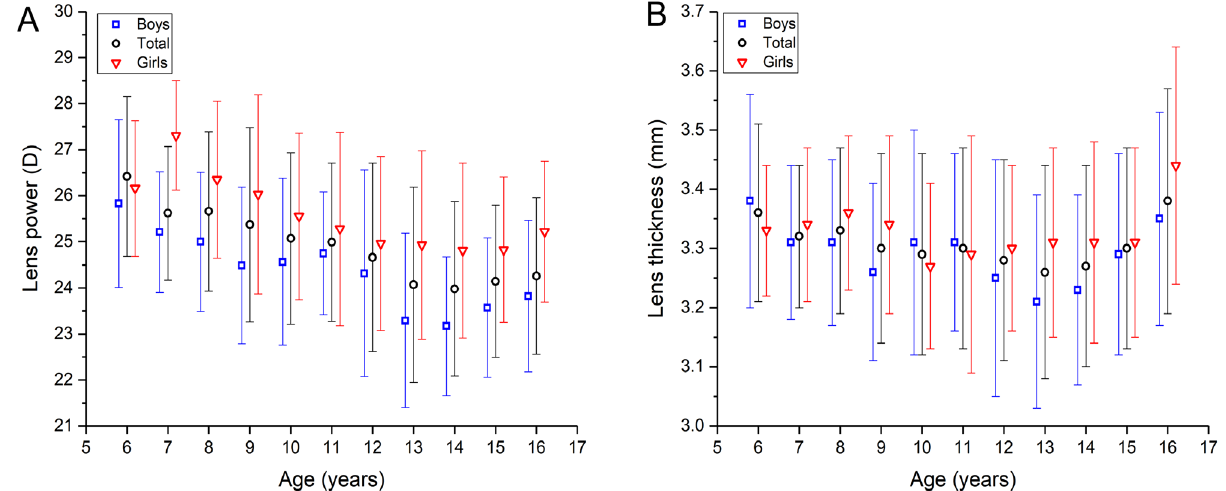
Figure 2. Distribution of lens thickness (A) and refractive lens power (B) in the Qinghai Children Eye Study, stratified by age and gender.